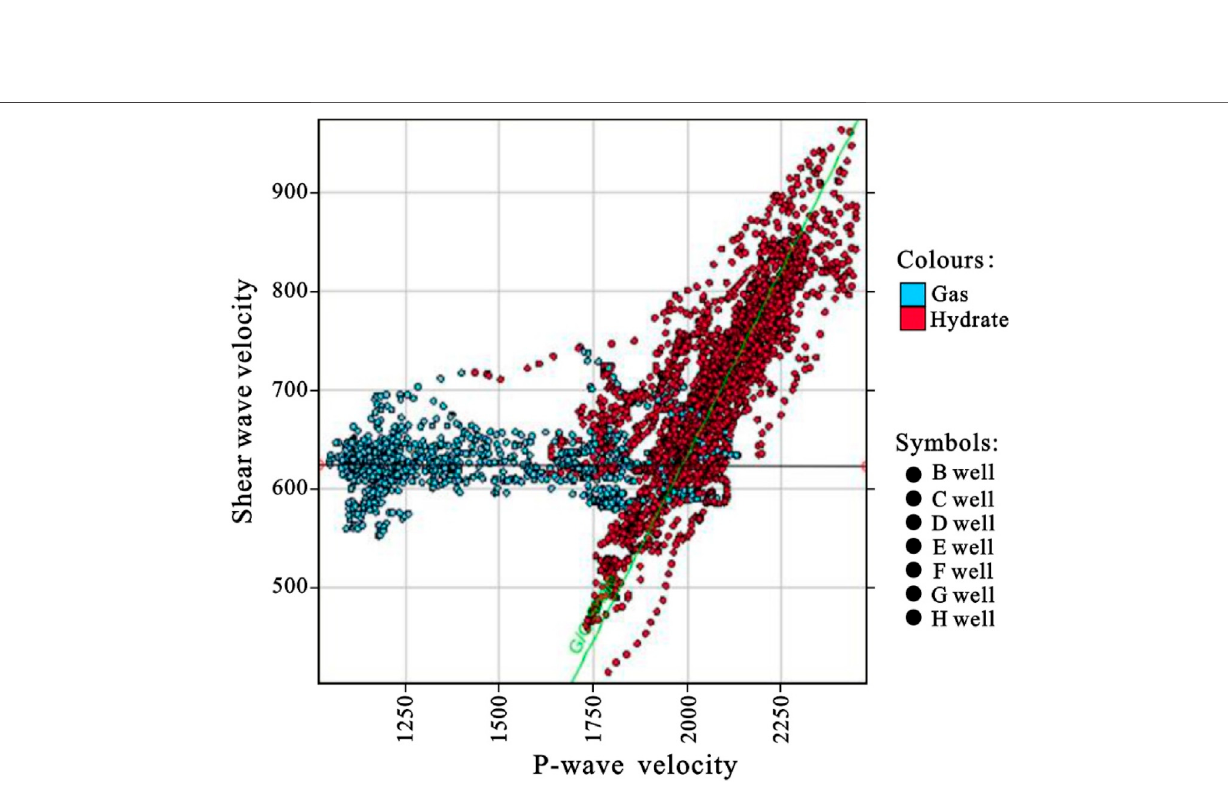
Frontiers in Earth Science |